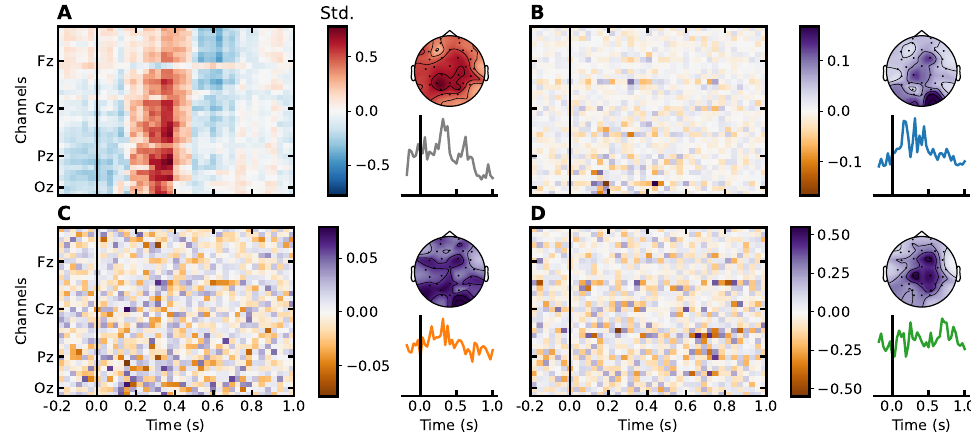
Figure 5. Spatiotemporal beamformer weights calculated using four blocks of data (of 1215 epochs) from Subject 01 from 0.2 s before until 1.0 s after stimulus onset. Regularized weights show an interpretable sparse pattern, whereas the empirical weights appear noisier. ( A ) Spatiotemporal activation pattern with spatial and temporal global field power. ( B ) STBF - STRUCT weights with spatial and temporal averages of absolute values. ( C ) STBF - SHRUNK weights. The shrinkage factor α = 0.05 was determined with the closed-form LOOCV method. ( D ) STBF - EMP